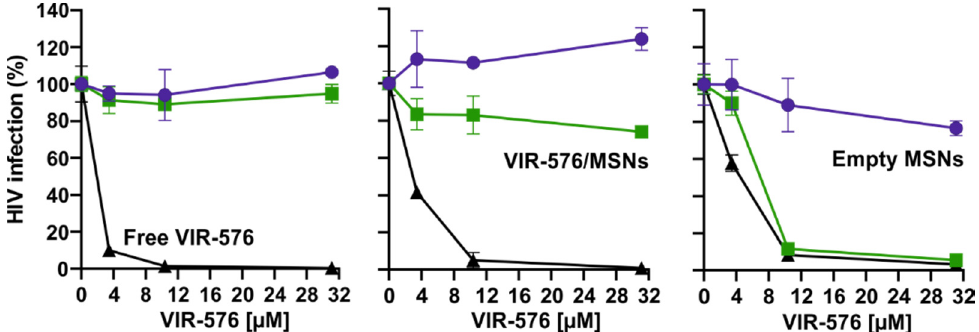
Figure 6. VIR-576-concentration-dependent HIV-1 NL4-3 infectivity inhibition as a function of pre-incubation time in 10% FCS for free peptide, and peptide released from MSNs. Color coding as indicated in the figures. See experimental for details.